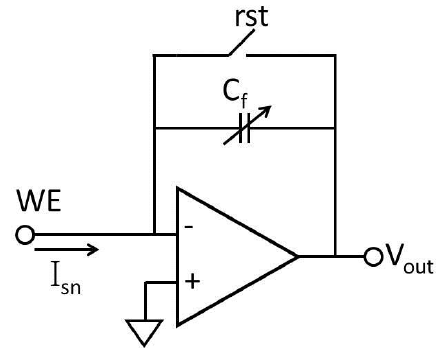
Figure 8. Capacitive feedback current readout circuit.